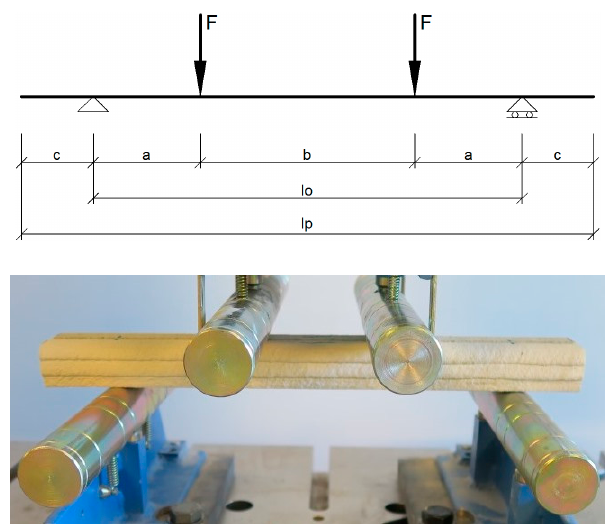
Figure 12. Four-point bending test scheme.